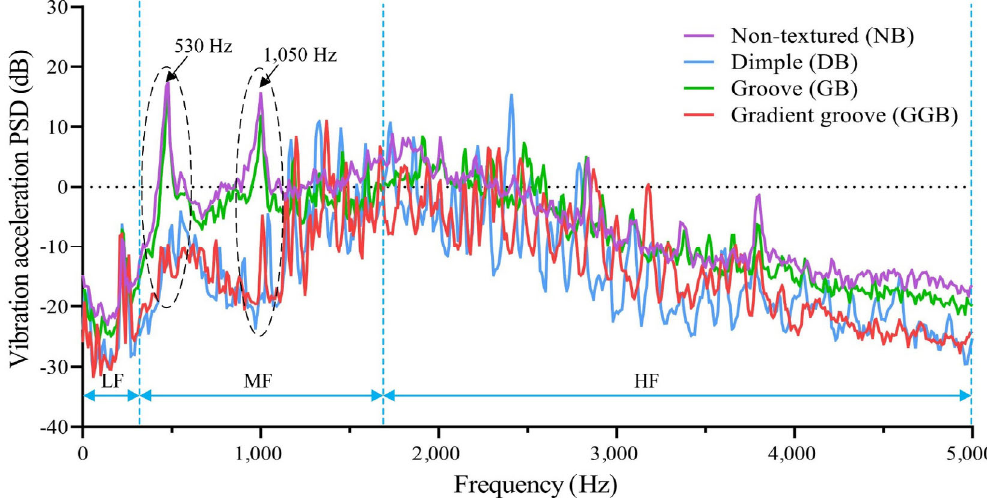
Fig. 11 PSD of vibration acceleration of four bearings.